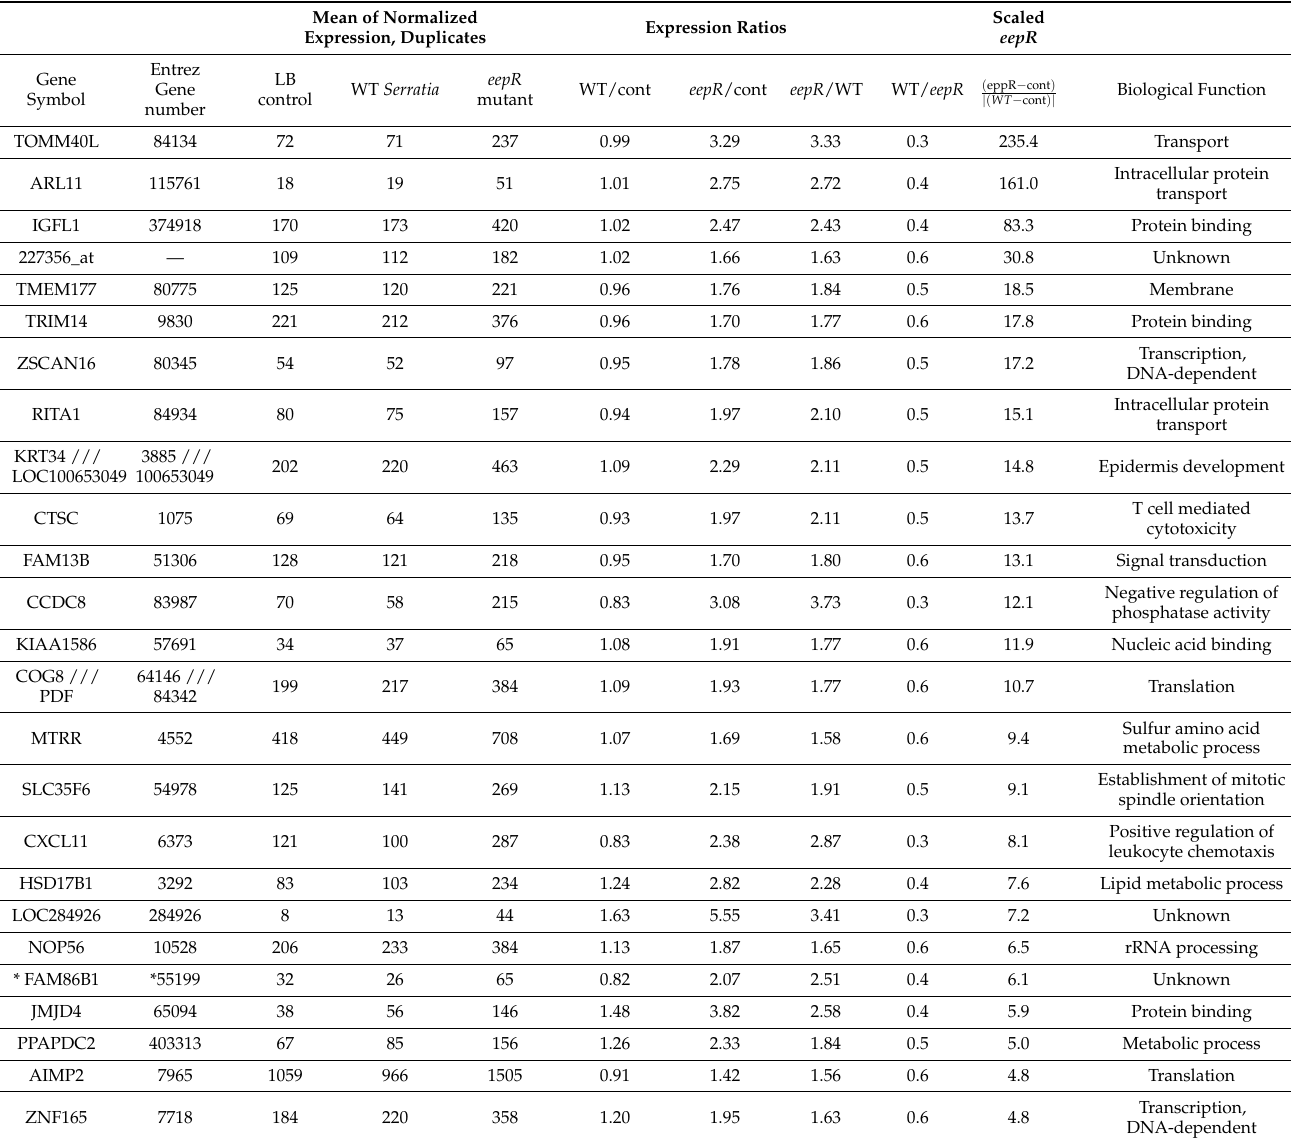
Table 5. Twenty-five genes with the highest scaled eepR values (i.e., relatively little effect of WT, relatively large increase by eepR ). Mean of Normalized Expression,